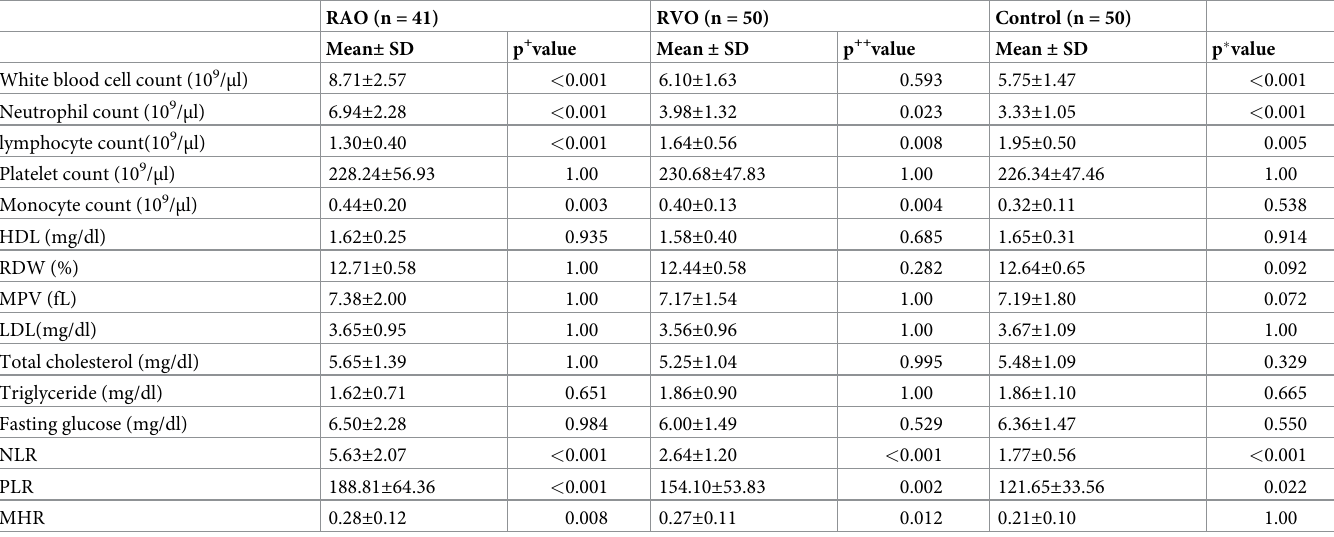
Table 3. The comparison of parameters of blood test among three